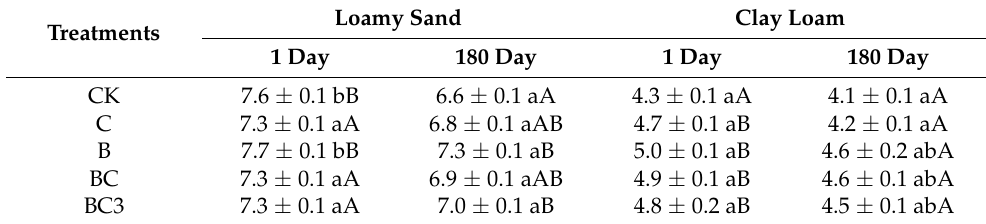
Figure 2. Dynamic changes in contents of NH 4+ -N and NO 3 − –N in soil solution during the experiment period ( A’ , A” ) sandy soil ( B’ , B” ) clay soil. Table 3. Soil pH comparison before and after